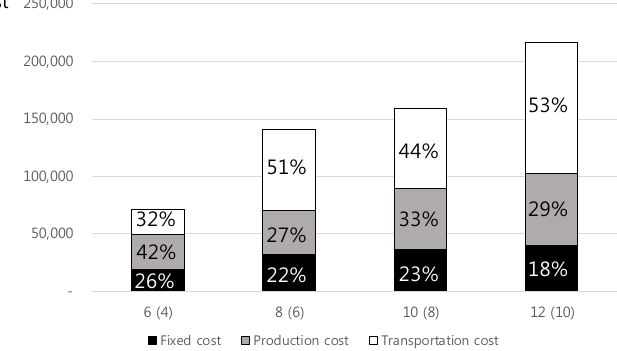
Figure 5. Cost comparison based on change in problem size.